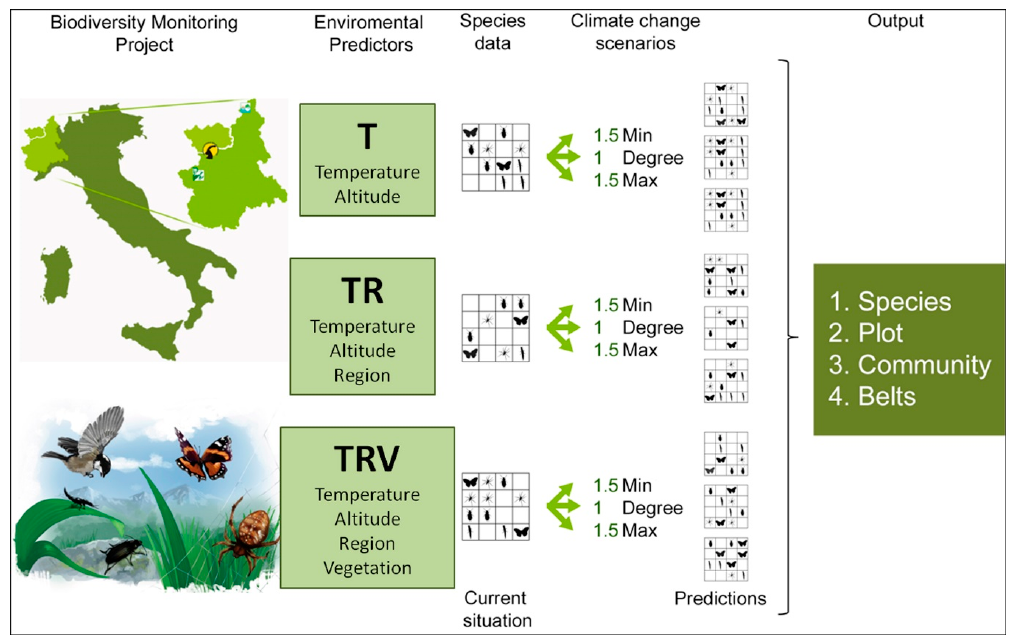
Figure 1. Conceptual framework of the modeling approach. Data on species presence and envi- ronmental variables were derived from the monitoring project started in 2007. Environmental varia- bles were combined to obtain 3 model classes, with an increasing number of constraints. Each of them, through Maxent simulations, produced the corresponding modeled current conditions, to which three different climate change scenarios were then applied. The results for the various climate change scenarios were compared to the Maxent current species